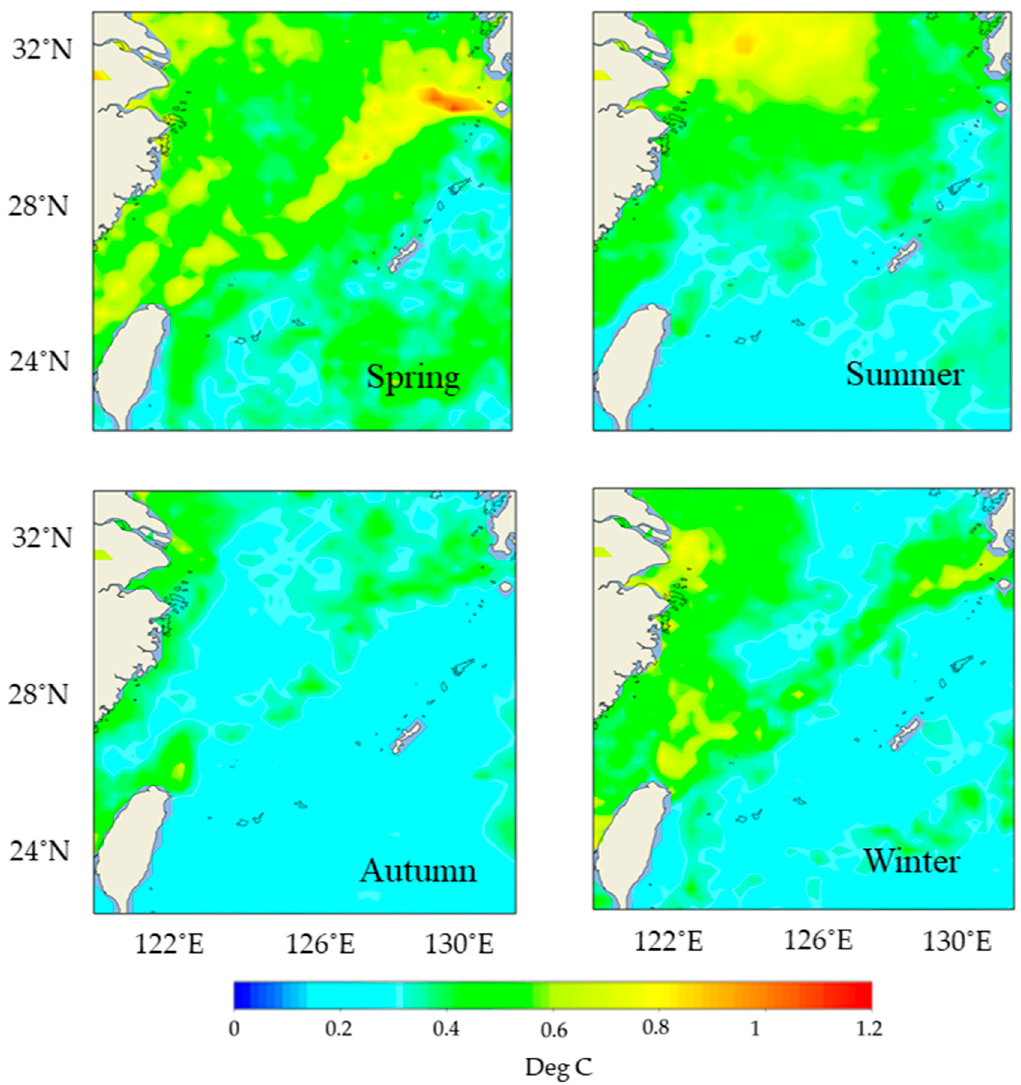
Figure 11. Spatial distribution of RMSE between LSTM predicted sea surface temperature and OSTIA data in four seasons, in which spring is from March to May, summer is from June to August, autumn is from September to November, and winter is from December to February. The unit of color bar is degrees Celsius.